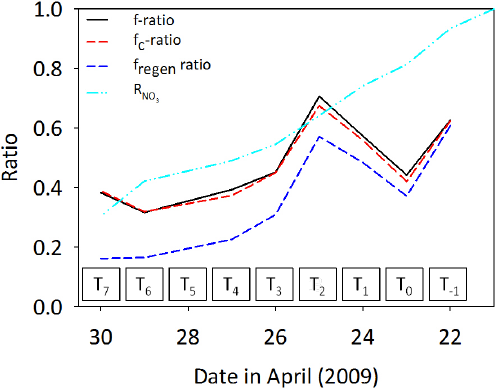
Figure 7. Changes in f ratio representations ( f ratio, f c ratio cor- rected for isotope dilution due to nitrogen regeneration, f regen ratio corrected for isotope dilution and the fraction of the nitrate pool represented by new rather than regenerated nitrate). The fraction of the nitrate pool represented by new nitrate is also presented ( R NO Note the reversal of dates to aid comparisons between